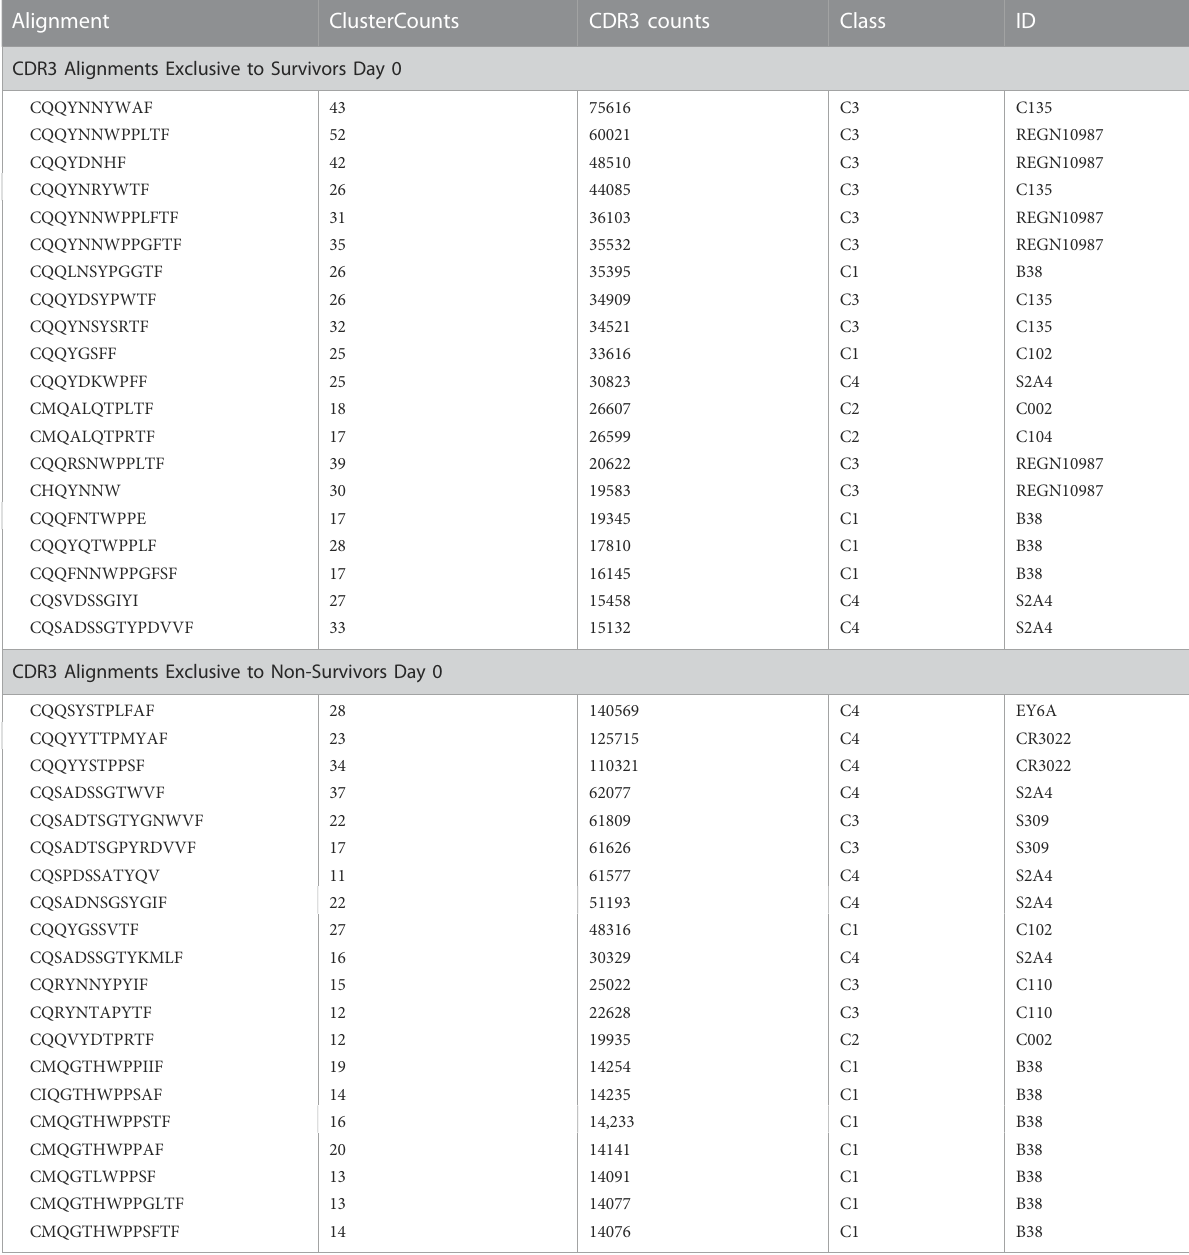
TABLE 2 CDR3 alignments exclusive to survivors day 0.